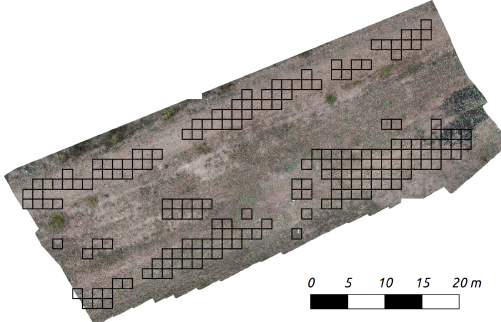
Figure 3. Orthomosaic RGB imagery from the 26 November 2018 survey overlaid with the outlines of tiles used for the extraction of hail size distribution